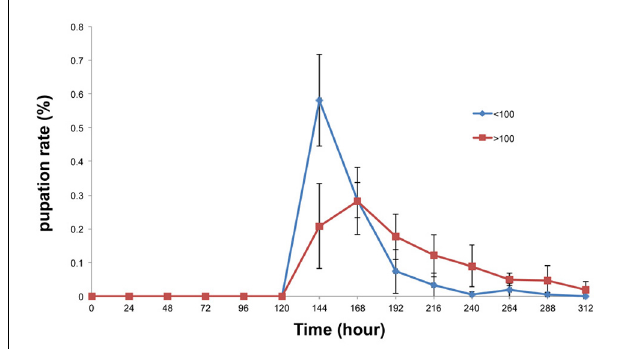
FIGURE 8 | Comparison of the pupation rates of the large and small population groups. Pupation peaked 24h later in the large population group (more than 100 larvae) than in the small population group (fewer than 100 larvae). At 144h after egg laying, a significant difference was detected between the groups with more than 100 pupae and less than 100 pupae ( p < 0 .